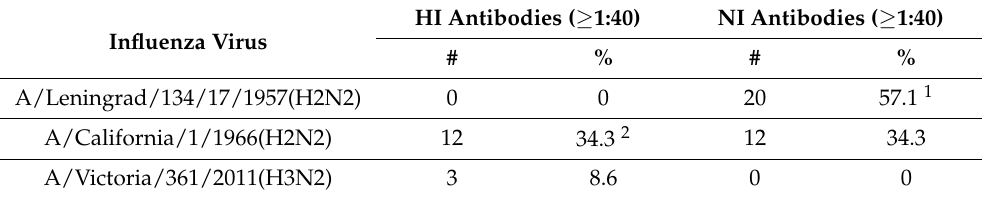
Figure 5. HI and NI antibody titers to A/Leningrad/134/17/1957(H2N2), A/California/1/1966(H2N2) and A/Victoria/361/2011(H3N2) in the sera of adults and elderly examined in 2013. ( A ). The elderly, ≥ 65 years old ( n = 35). ( B ). Adults, 21–38 years old ( n = 6). * p < 0.05, ** p < 0.01. The herd immunity to influenza viruses A/Leningrad/134/17/1957(H2N2), A/Califor- Table 3. The levels of ‘herd’ immunity to antigens to HA and NA of A/Leningrad/134/17/1957(H2N2), nia/1/1966(H2N2) and A/Victoria/361/2011(H3N2) as assessed by antibody levels ≥ 1:40, A/California/1/1966(H2N2) and A/Victoria/361/2011(H3N2) among elderly patients examined in are presented in Table 3. Despite the fact that there were no HI antibodies to 2013 ( n =